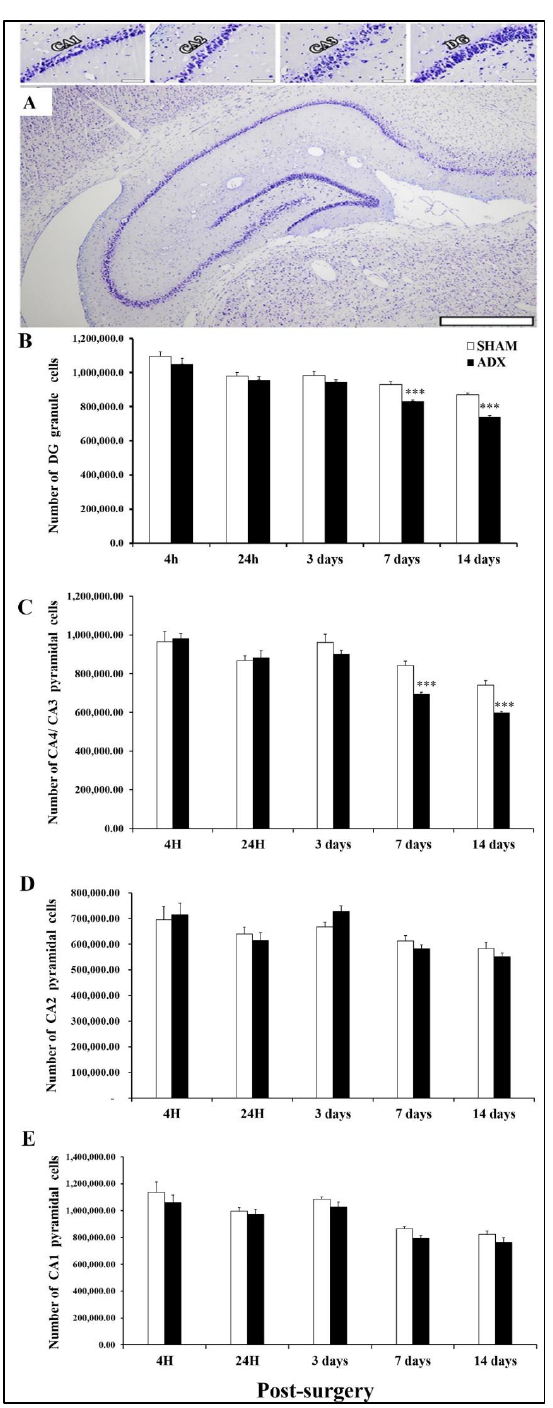
Figure 3. Stereological evidence of non-selective cell death in the hippocampus following adrenalectomy over the course of (4 h, 24 h and 3, 7, 14 days). ( A ) A general view of hippocampus and cell counting